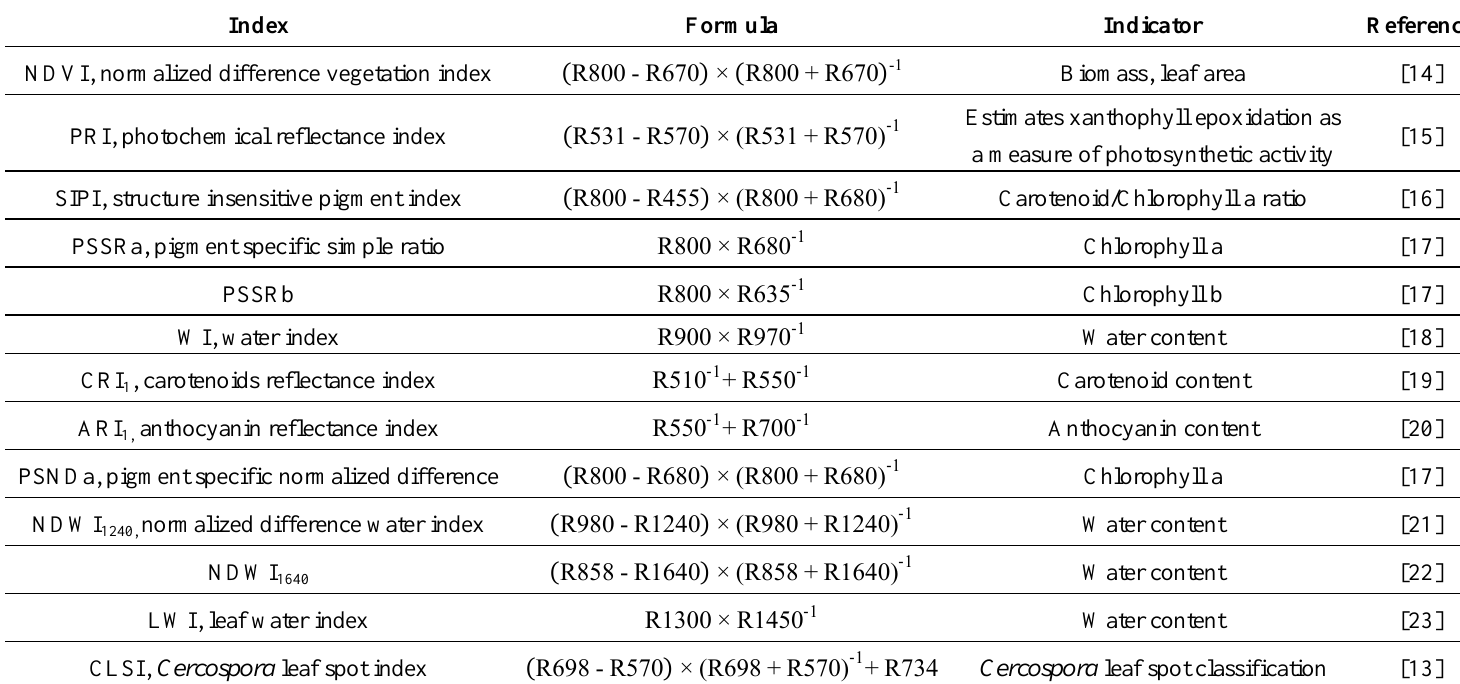
Table 1. Vegetation indices calculated out of two or three wavelengths indicating traits related to physiological status of